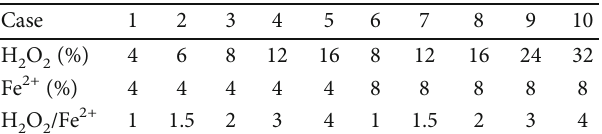
Table 2: Reagent proportioning scheme for the speci fi c resistance test.